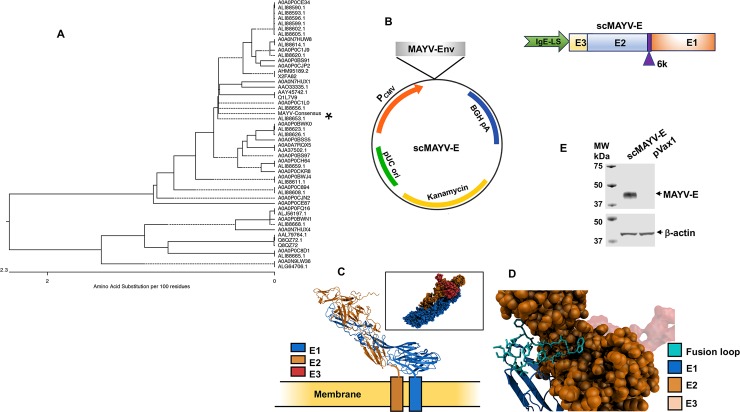
Development and characterization of a synthetic consensus Mayaro DNA vaccine.A) Phylogenic analysis based on neighbor joining evaluation of MAYV-envelope sequences deposited in GenBank. The position of the scMAYV-E vaccine sequence in this tree is noted with an asterisk ‘*’ (B) Schematic of the scMAYV-E vaccine construct generated. scMAYV-E encodes all three envelope glycoproteins (E1, E2, and E3) and the 6K/TF polypeptide linked by protease cleavage sites. The IgE-leader sequence was inserted at the 5’ end to increase protein expression. (C) A computer-generated MAYV antigen model. (D) View of E1 showing fusion loop in cyan. The fusion loop is generally conserved among the alphaviruses. E3 (transparent red) is shown to provide orientation. The highly conserved MWGG sequence is visible at the loop’s rightmost position. The M residue is buried and predicted to interact with nearby TYR and PRO residues of E2. The backbone portion of M participates in H-bonds with the nearby G at position i+3 to form a b-turn. (E) Western analyses of lysates from scMAYV-E or pVax1 transfected 293T cells incubated with pooled day 35 sera from scMAYV-E immunized mice. β-actin was used as a loading control for transfected 293T cell lysates.